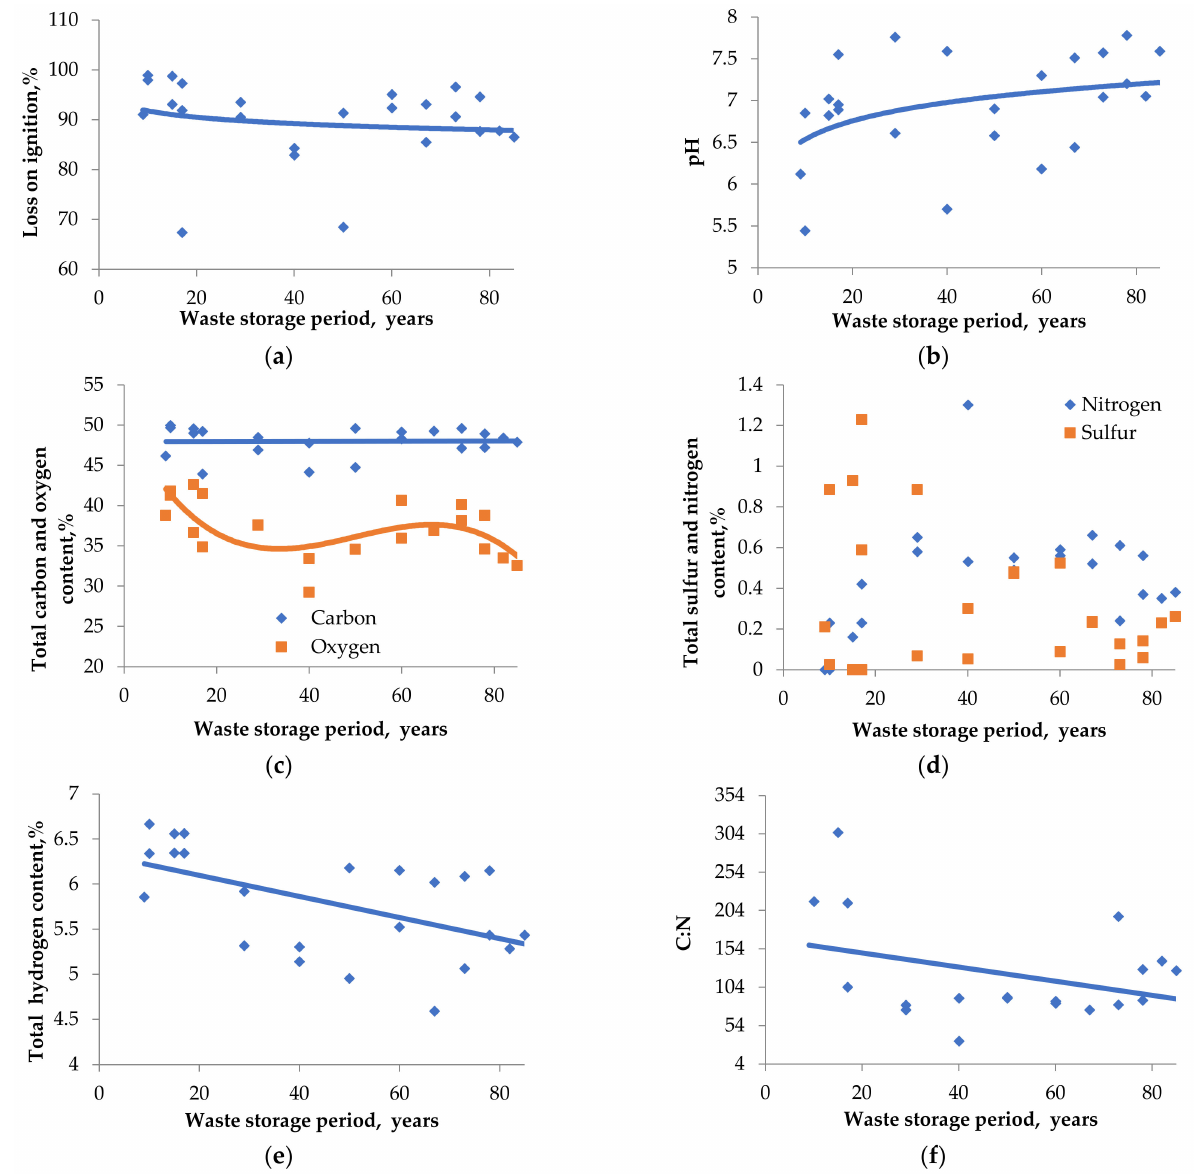
Figure 3. Results of physicochemical analysis of BWW samples: ( a ) loss on ignition; ( b ) pH; ( c ) carbon and oxygen content; ( d ) sulfur and nitrogen content; ( e ) hydrogen content; ( f ) carbon to nitrogen